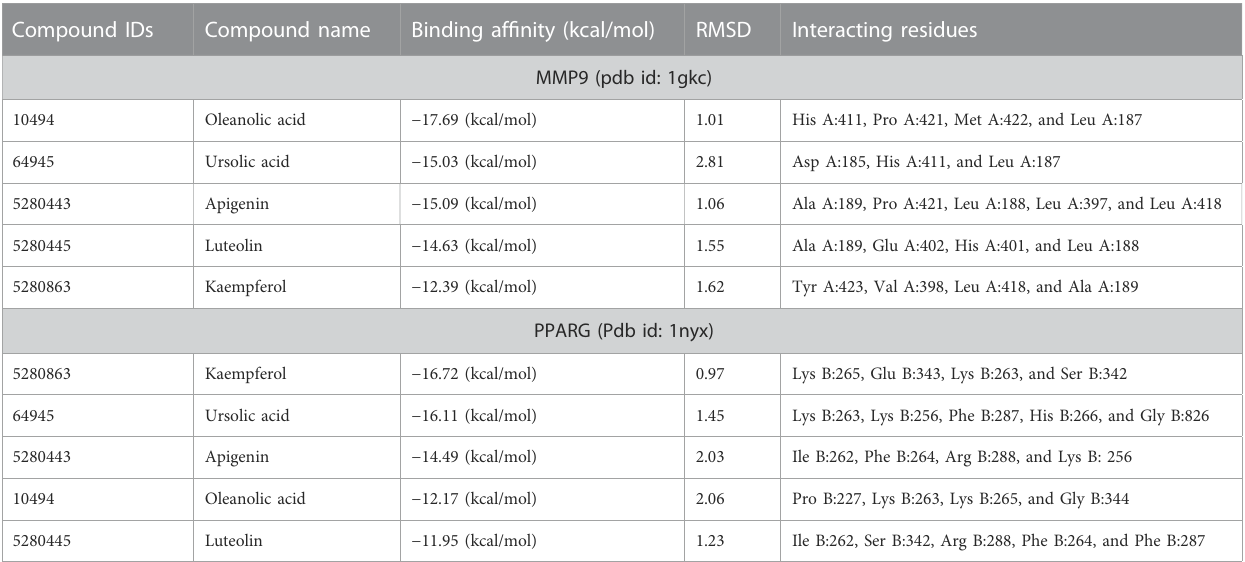
TABLE 4 Binding af fi nity and RMSD values of core targets with active compounds. Compound